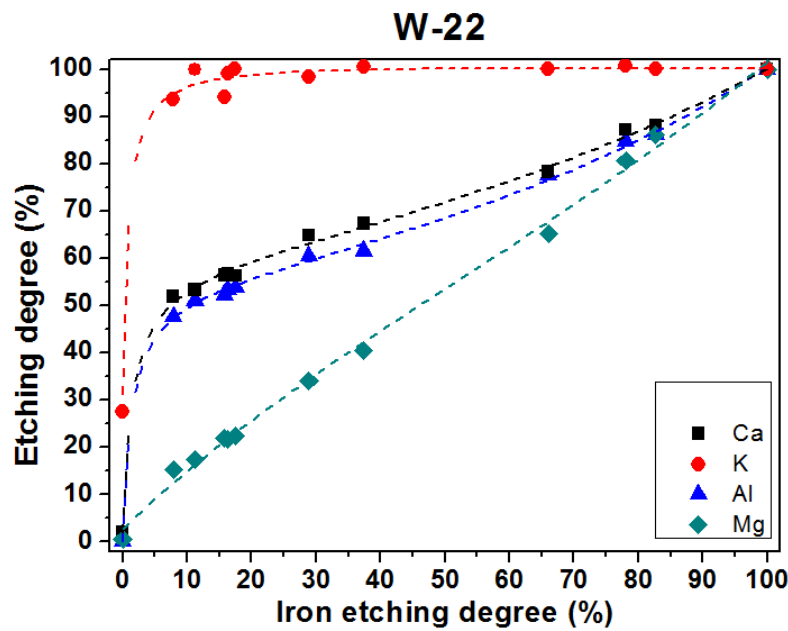
Figure 2. The degree of promotor etching related to the degree of iron etching in the precursor W-22. Table 2. Concentration of precursors in iron